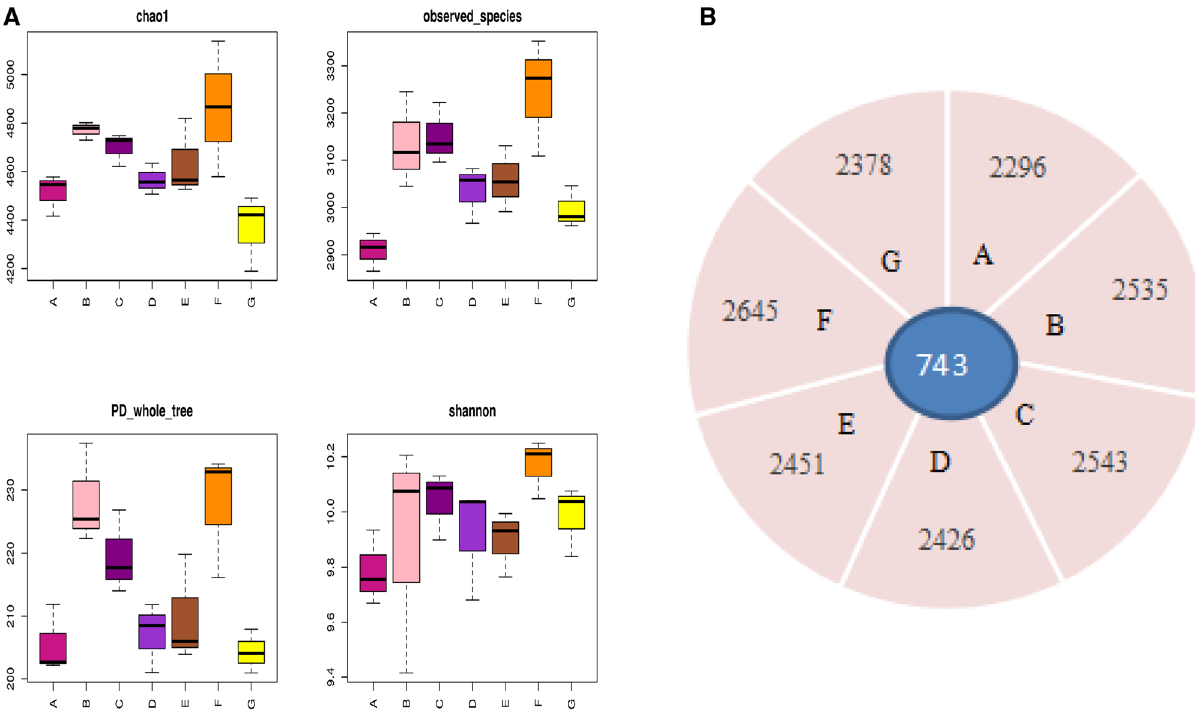
Figure 4. ( A ) Chao1, observed-species, PD_ whole _tree, and Shannon index of bacteria of different continuous cropping year. Uppercase of A, B, C, D, E, F, and G represent 5, 10, 15, 20, 25, 30, and 30 years cropping, respectively. ( B ) Venn diagram of the bacteria of different continuous cropping year. A, B, C, D, E, F, and G represents 5, 10, 15, 20, 25, 30, and 30 years cropping, respectively.